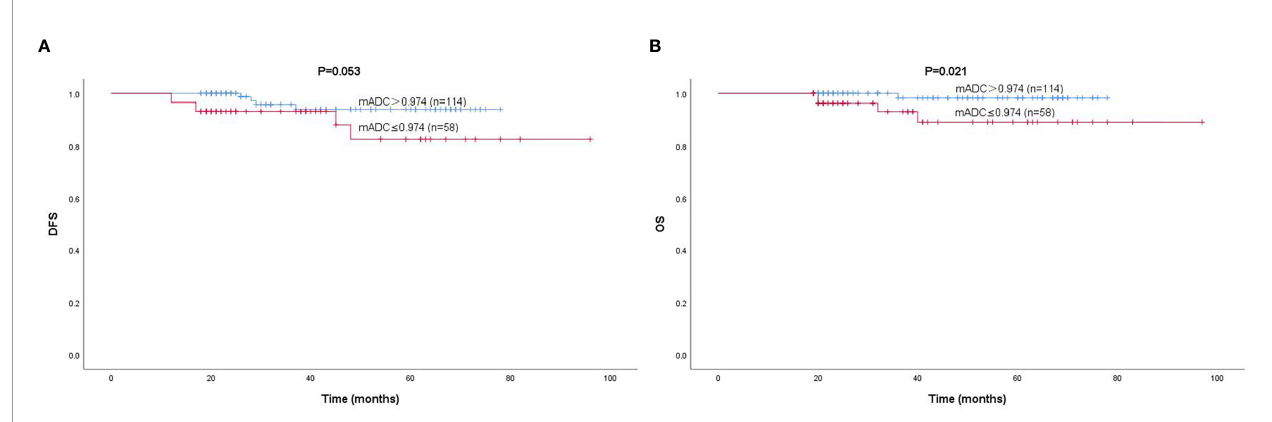
FIGURE 4 | Kaplan – Meier curves for the DFS (A) and OS (B) of 172 patients, according to mADC. The cutoff value was 0.974×10 -3 mm